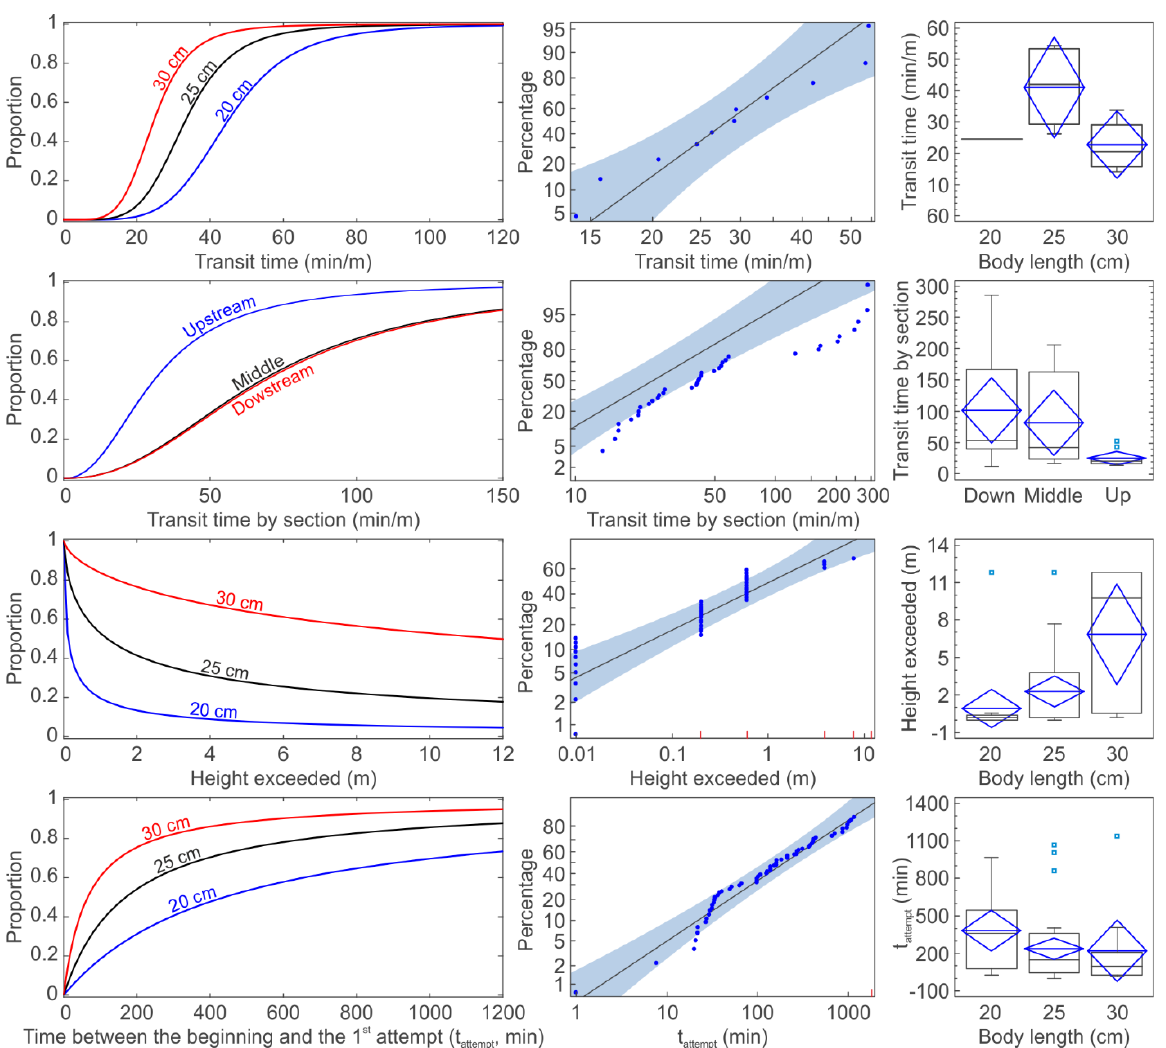
Figure 5. Left column graphs: illustrative log-logistic survival models as a function of body length (20, 25, and 30 cm, which represents 95% of the fish sample under study) for the different metrics. Middle column graphs: probability plots for evaluating the fit of the different models (ideally the points on the plot form a linear pattern and should lie within the 95% confidence bands which are shaded in blue). Right column graphs: box-plot and diamond distribution for the different metrics (body length was categorized in three groups of 20, 25, and 30 cm, respectively).